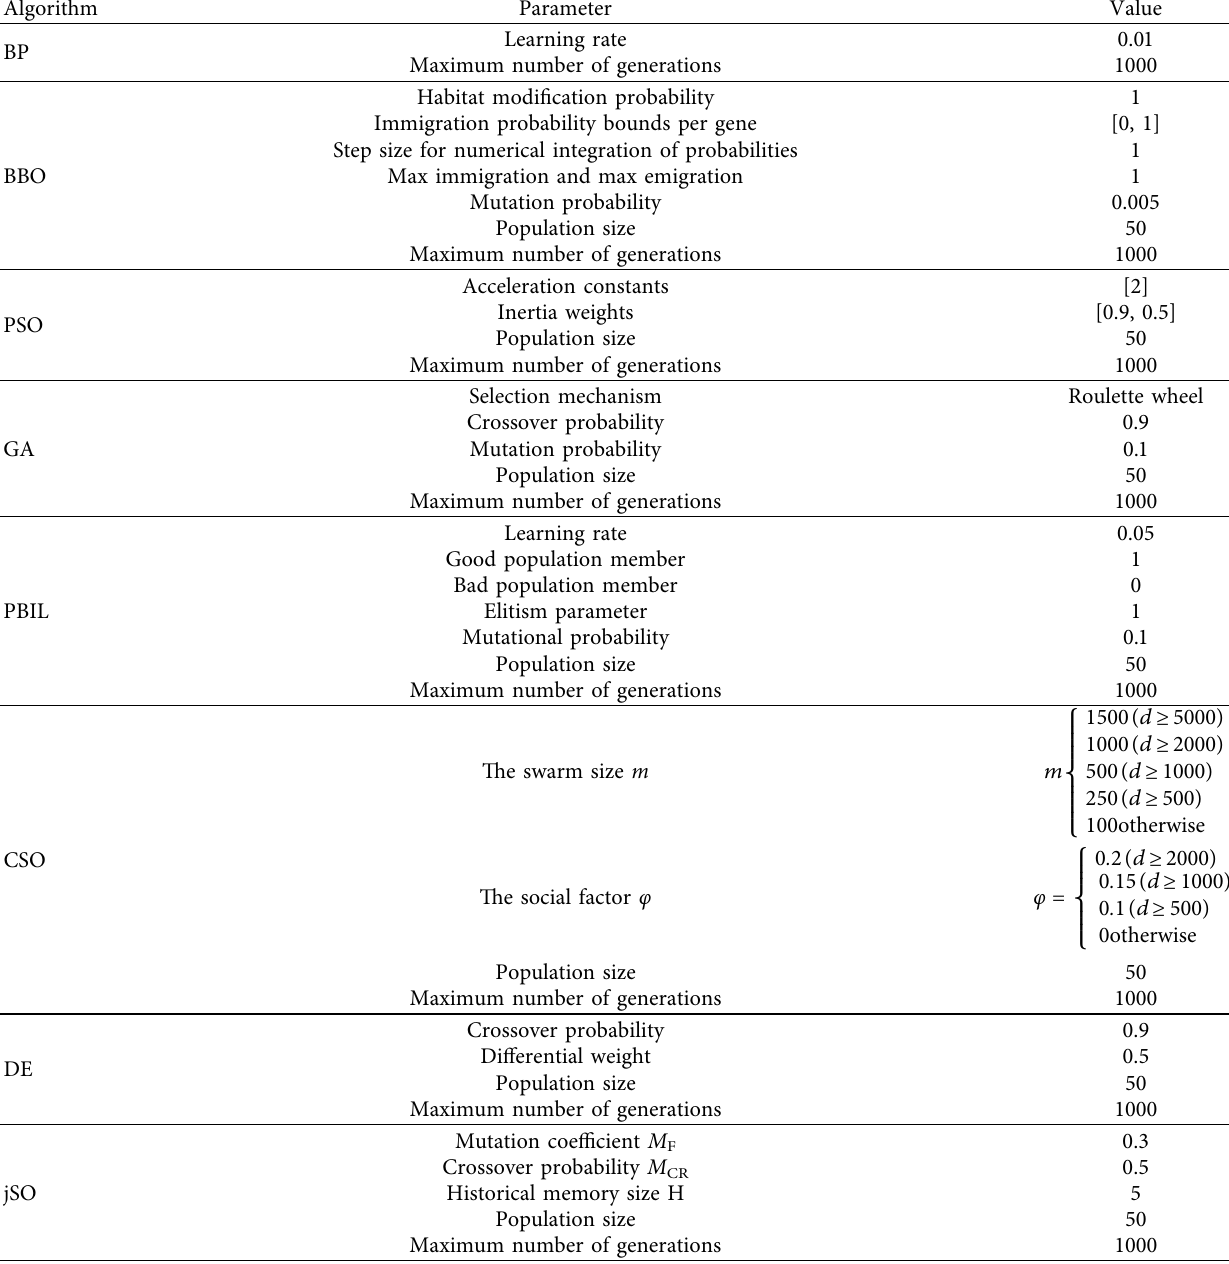
Table 3: Initial parameters used in learning algorithms.